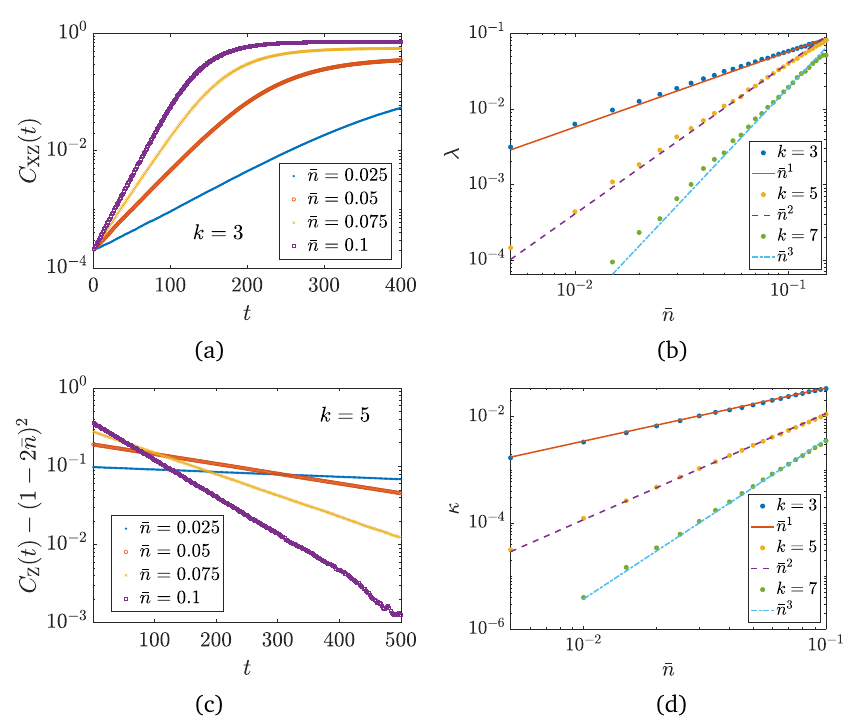
Figure 1: The correlation functions for random QA model with N = 20000 and ( t ) vs time on the semi-log scale. (b) The Lyapunov f = 0.5. (a) The OTOC C XZ exponent λ vs n on the log-log scale for various k .(c) The auto correlator C time on the semi-log scale. (d) The exponent κ vs n on the log-log scale for various k